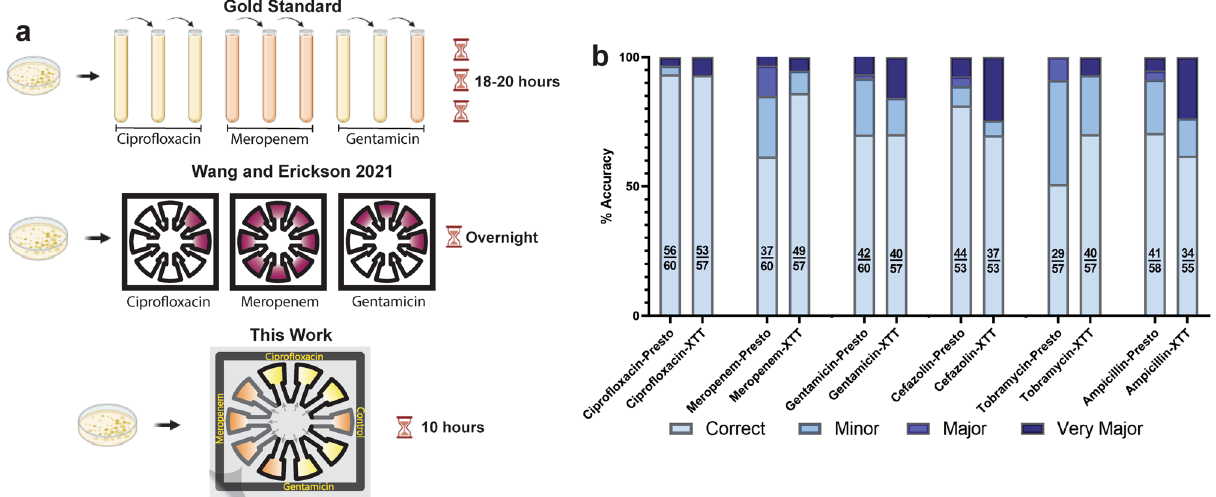
Figure 2. Bac-PAC compared to other technologies ( a ) Comparison of time and equipment of broth dilution (top), previous work (middle) and this work (bottom) ( b ) Bac-PAC four-fold dilutions results. Fractions represent number of correct samples over number of total